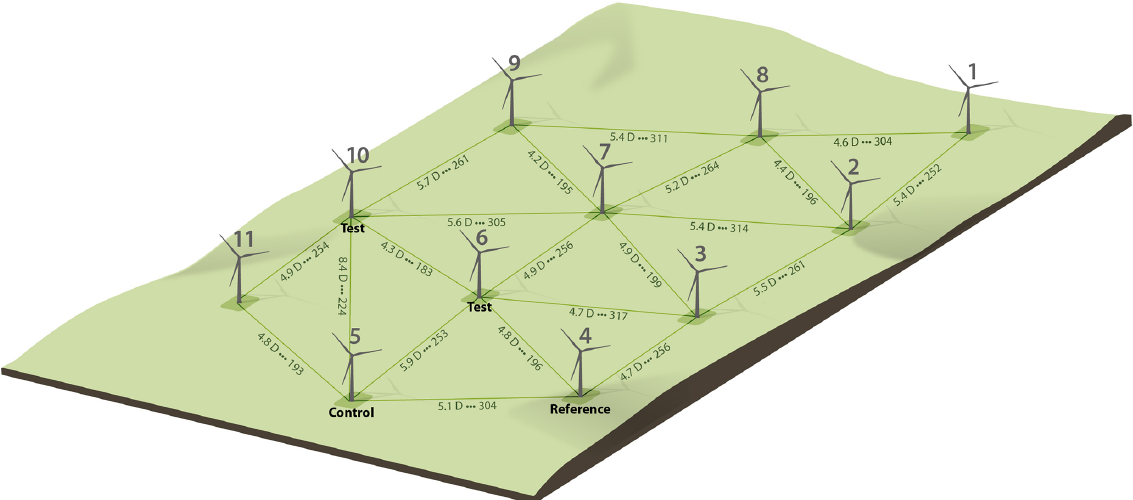
Figure 1. Layout, including interturbine spacings in terms of turbine rotor diameters ( D ), of the wind farm used in this experiment. The figure also indicates the wind directions by which one turbine wakes another. See Fig. 2 for direction conventions.